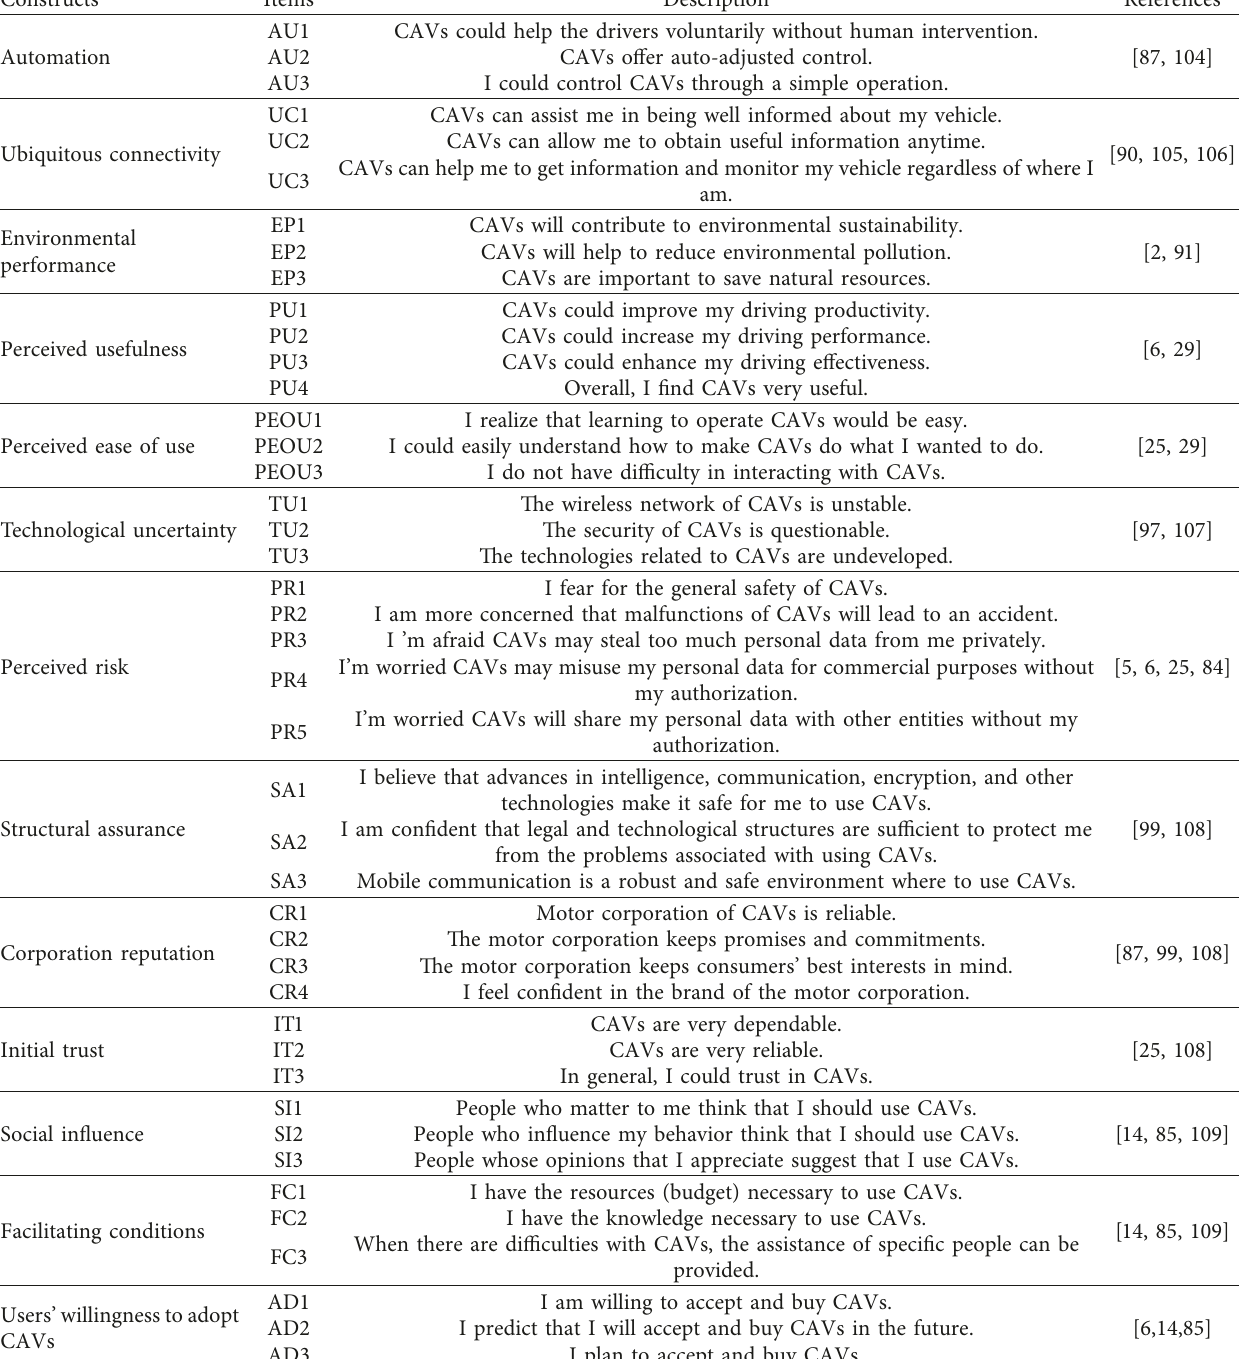
Table 2: Measurement